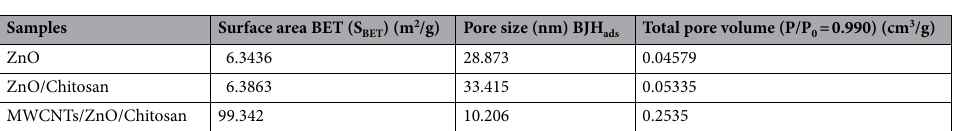
Table2. Surface area, volume and pore size distribution of ZnO, ZnO/Chitosan and MWCNTs/ZnO/Chitosan from nitrogen adsorption–desorption isotherm measurements.